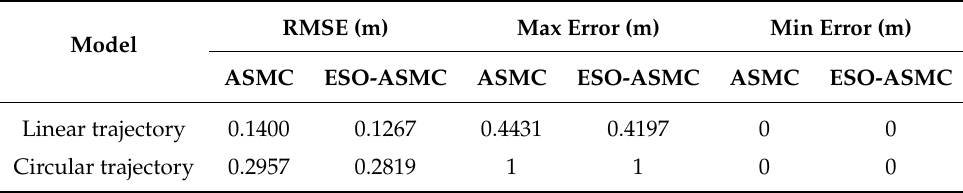
Figure 3. Linear trajectory tracking for WMR considering skidding and slipping. ( a ) Trajectory tracking. ( b ) Position tracking error. ( c ) Linear velocity tracking. ( d ) Angle velocity tracking. ( e ) Velocity tracking error. ( f ) Control input. ESO = extended state observer; ASMC = adaptive sliding mode controller. Table 3. Performance comparison of ASMC and